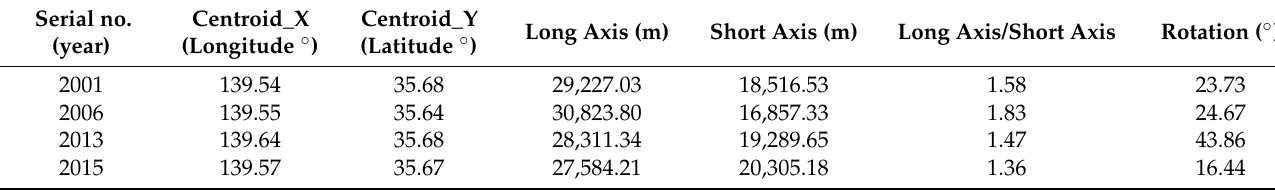
Table A1. SDE parameters of SUHI hot spots from 2001 to